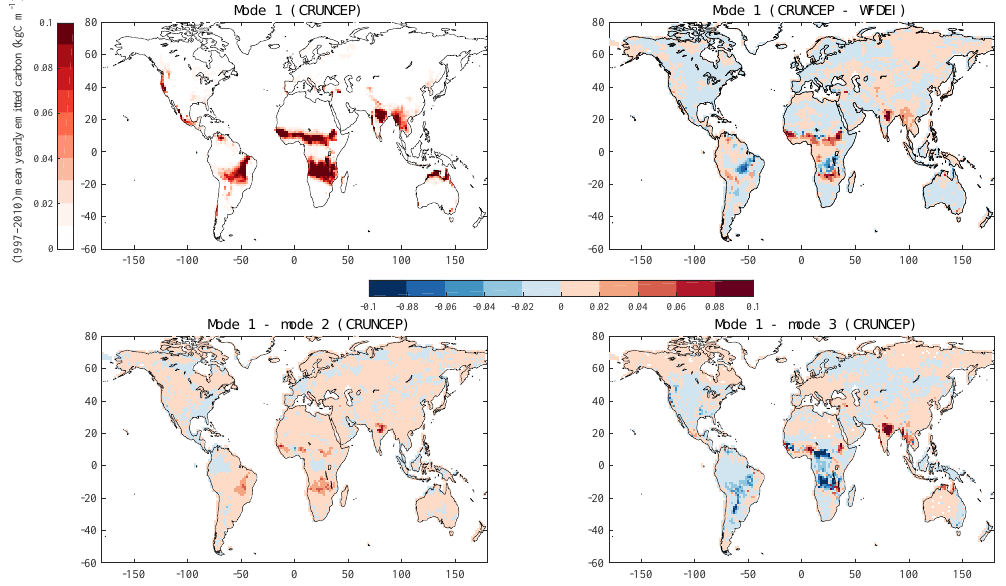
Figure B1. Emitted carbon difference maps between the four runs performed to analyse the sensitivity of INFERNO to ignitions (our three ignition modes; see Sect. 2.1.1) and meteorology (CRU-NCEP and WFDEI-GPCC).